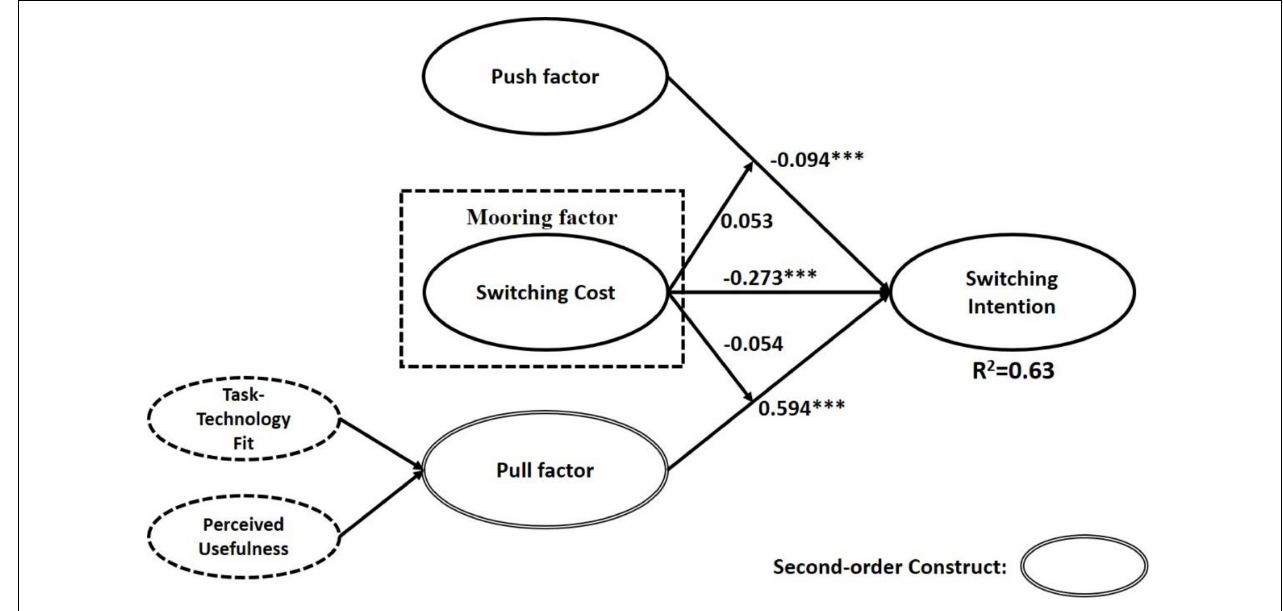
FIGURE 2 | Research analysis result. ∗∗∗ p <